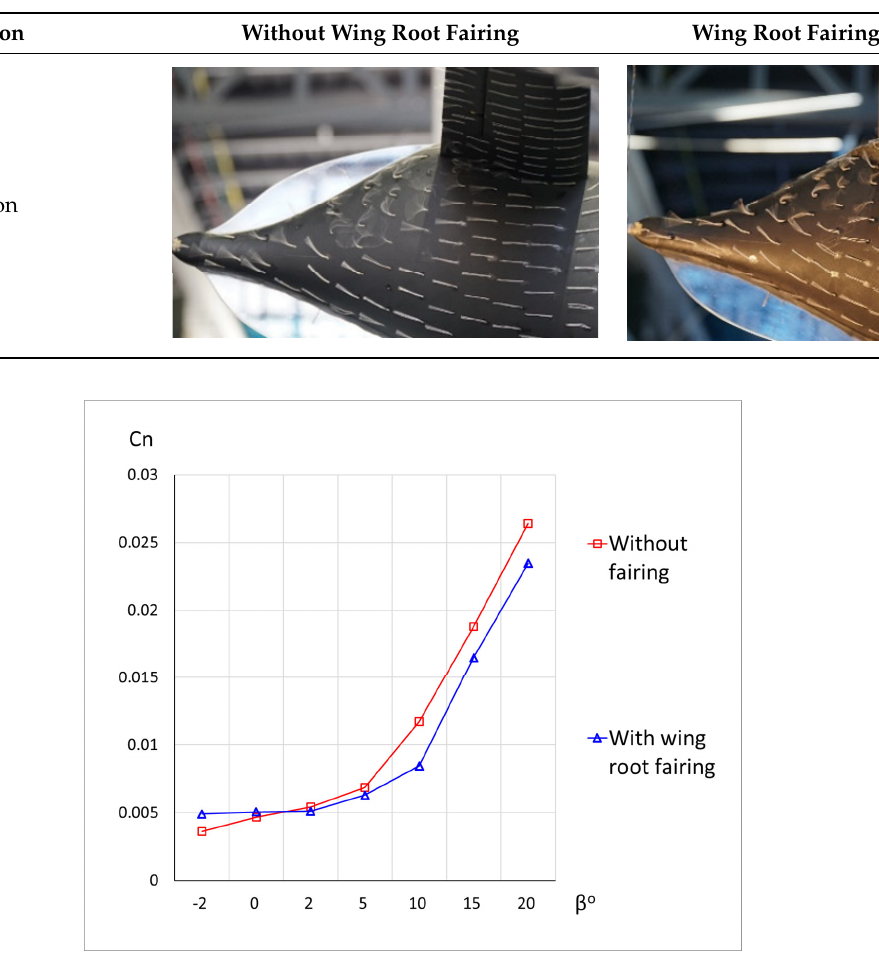
Table 6. Aft fuselage tuft flow visualization with wing root fairing.